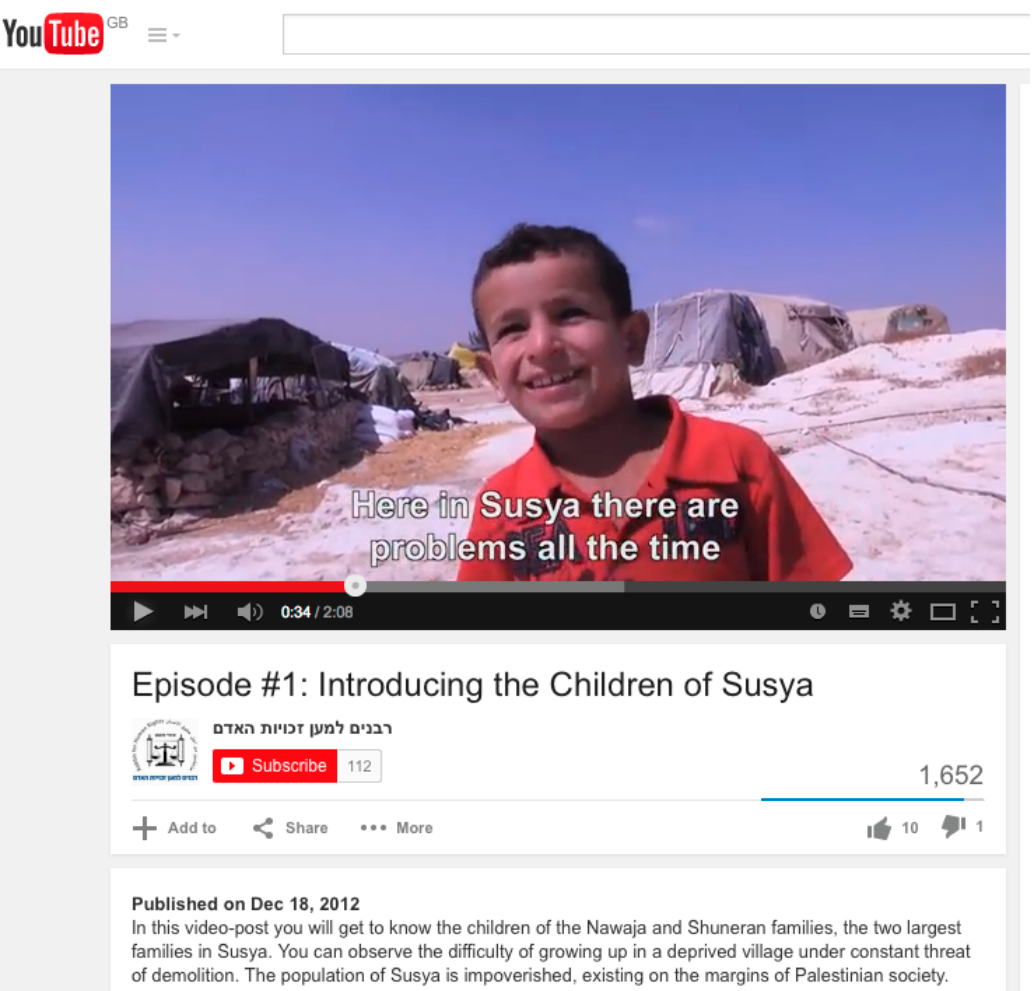
Figure 15. Screen grab from RHR’s YouTube video entitled ‘Introducing the Children of Susiya’. (Accessed on 17 October 2015).